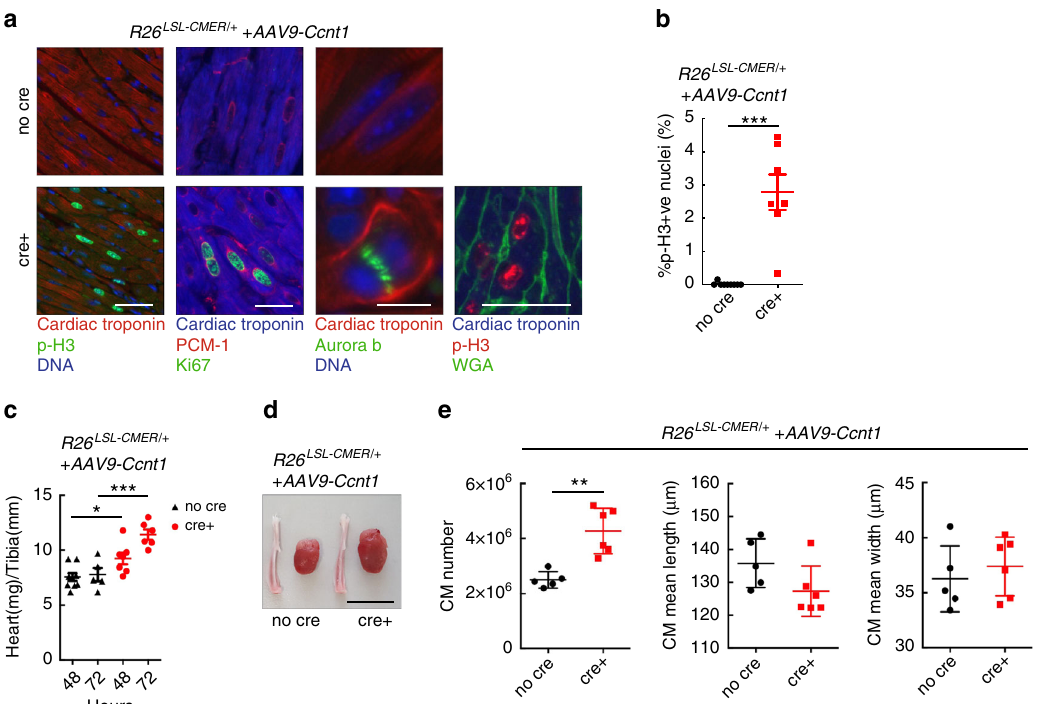
Fig. 9 Overexpression of Cyclin T1 in the adult heart facilitates Myc-driven proliferation of adult cardiomyocytes. a Immuno fl uorescent staining of cardiac troponin, p-H3,Ki67, PCM1, wheat germ agglutinin (WGA) and aurora B in control ( R26 LSL-CMER/ + ; no cre) and Myh6-Cre ; R26 LSL-CMER/ + ( R26 LSL-CMER/ + ; cre + ) adult mouse heart isolated 4 weeks post systemic infection with an adeno-associated virus encoding Ccnt1 ( AAV9-Ccnt1 ) and 48 h post administration of tamoxifen. Representative images based on analysis of fi ve independent mice. Scale bars represents 10 μ m (aurora B) and 50 μ m (all others). b Quanti fi cation of p-H3-positive nuclei percentage in control ( R26 LSL-CMER/ + ; no cre, n = 9) and Myh6-Cre ; R26 LSL-CMER/ + ( R26 LSL-CMER/ + ; cre + , n = 7) adult mouse heart isolated 4 weeks post systemic infection with an adeno-associated virus encoding Ccnt1 ( AAV9-Ccnt1 ) and 48 h post administration of tamoxifen. Means are taken from fi ve images per mouse; Mean and s.e.m shown. Unpaired t -test; no cre vs cre + P < 0.0001. c The weight (mg) of hearts isolated from control ( R26 LSL-CMER/ + ; no cre, n = 9 48 h, n = 5 72 h) and Myh6-Cre ; R26 LSL-CMER/ + ( R26 LSL-CMER/ +